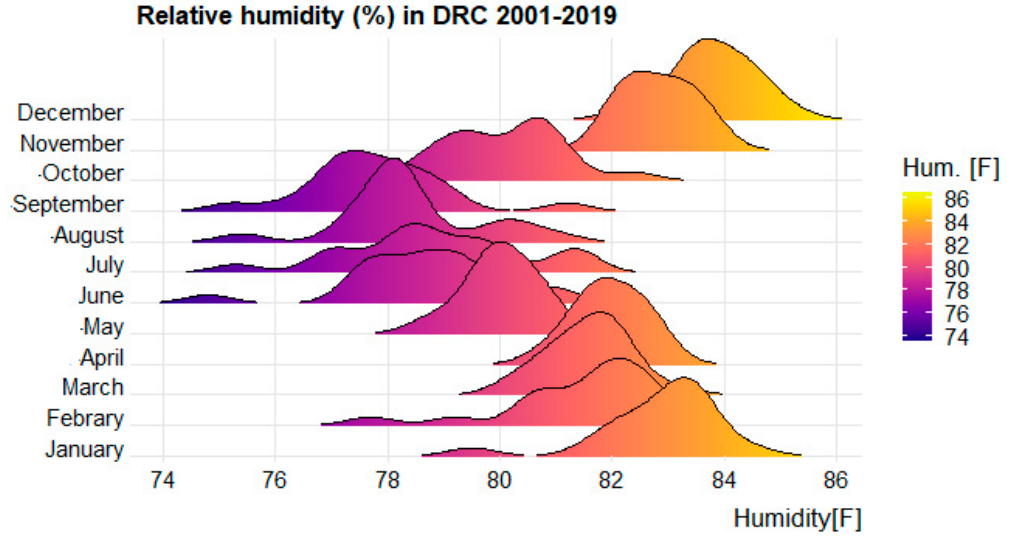
Figure A3. Relative humidity (%) in DRC (2001–2019).